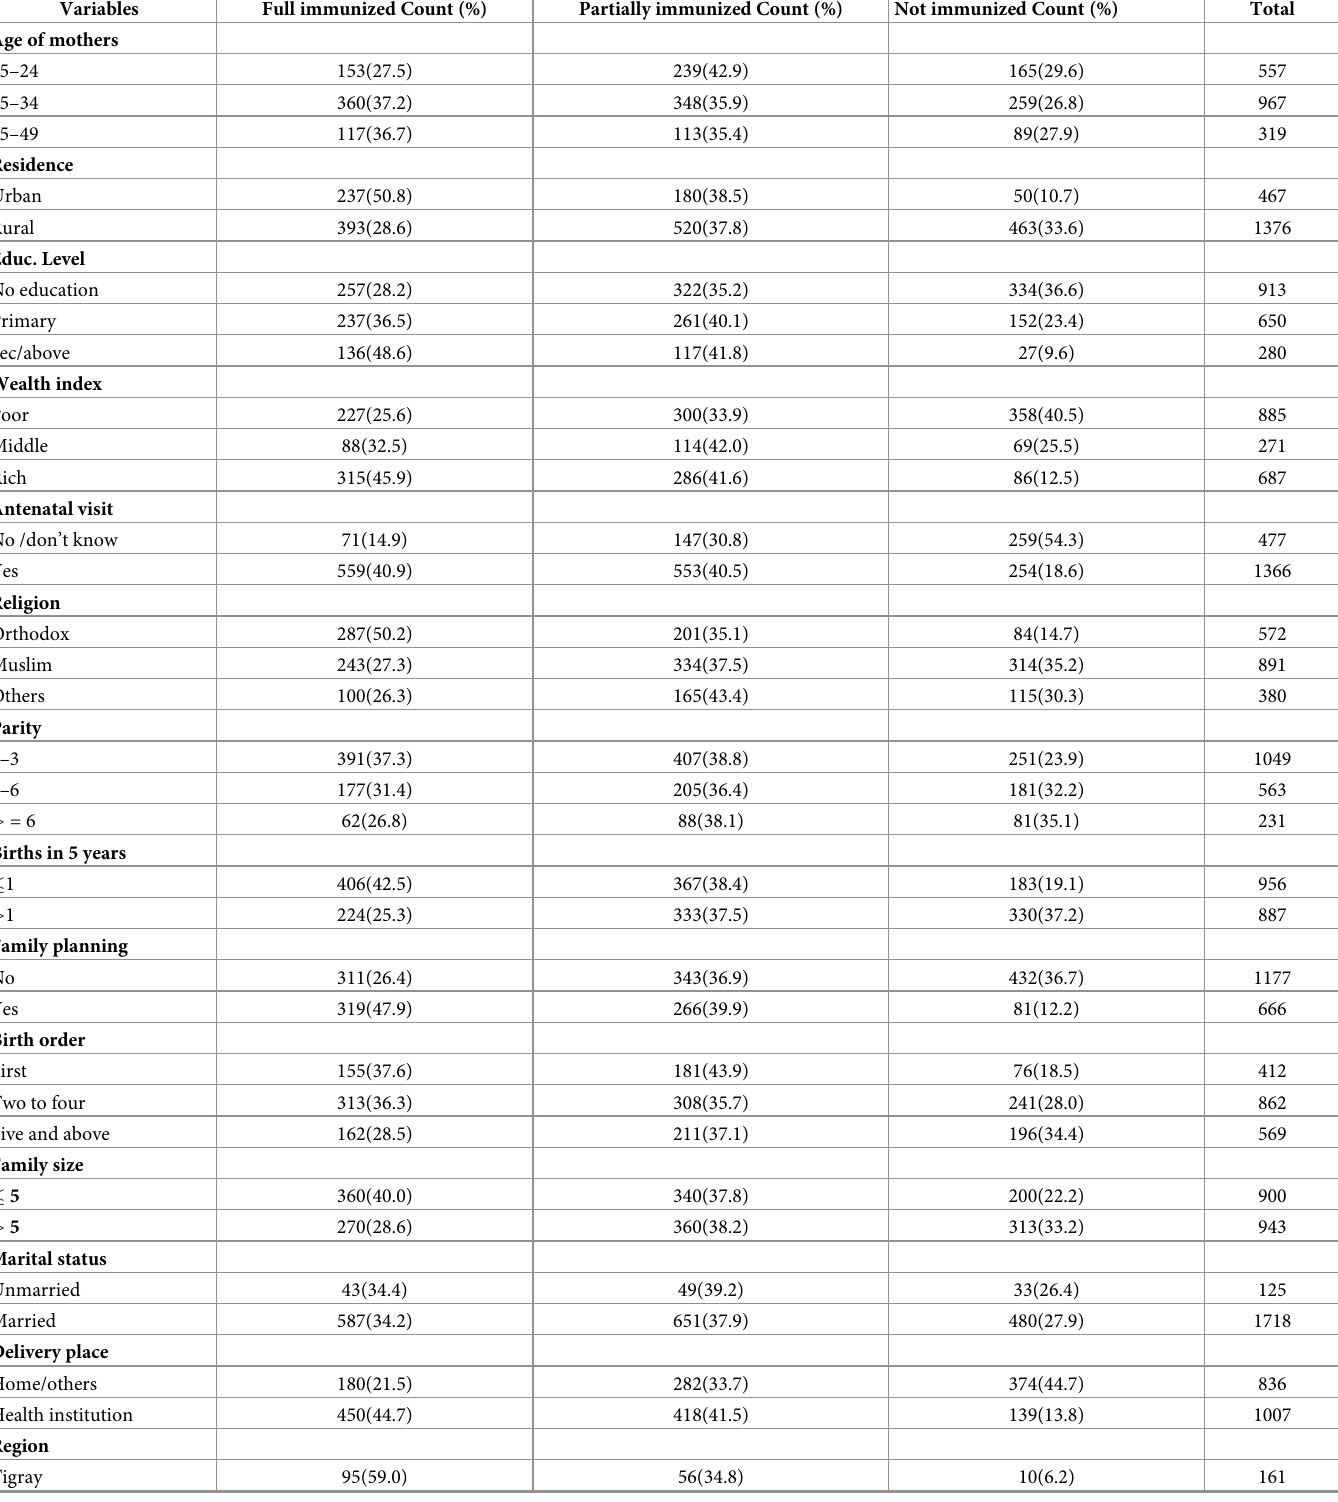
Table 2. Socio-demographic and other characteristics of children’s immunization status, mini EDHS 2019 ( n = 1 , 843